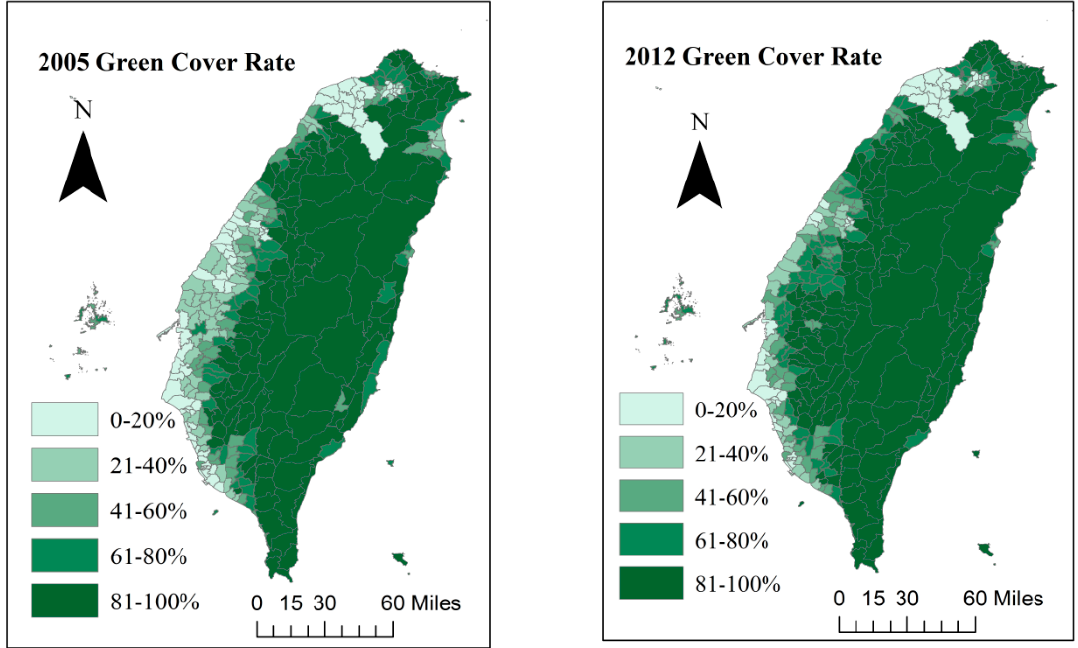
Figure 2. Green coverage changes in Taiwan over the eight study years.